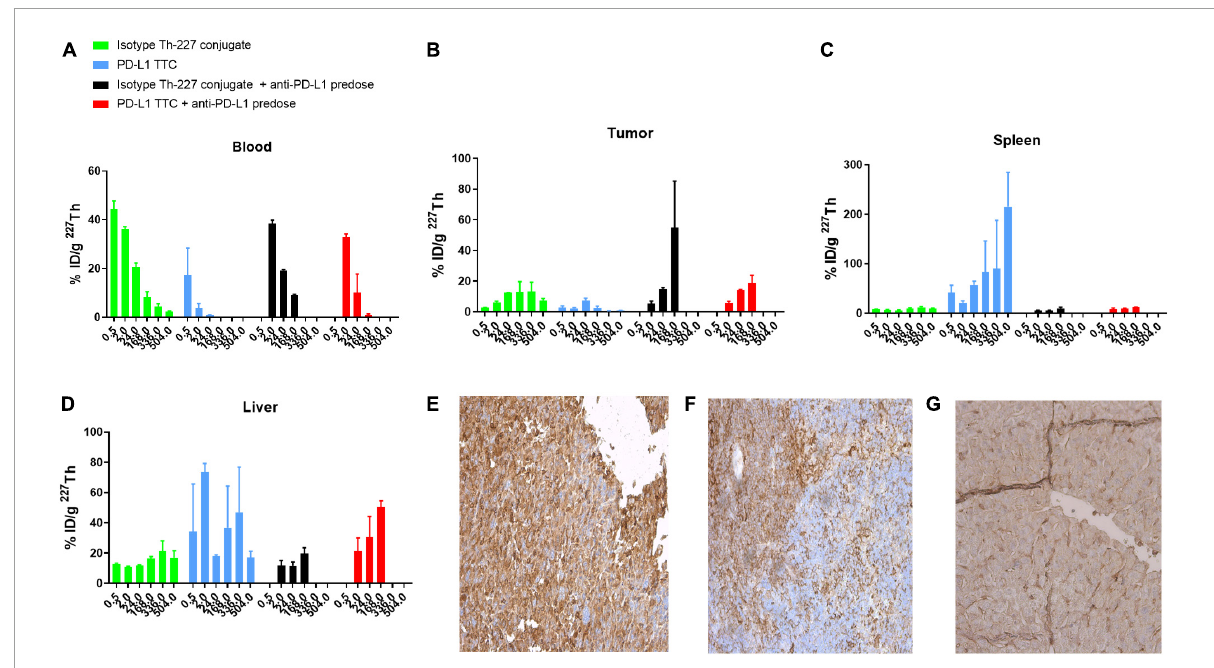
FIGURE3 (A–D) Biodistribution of 500 kBq/kg isotype Th-227 conjugate or PD-L1-TTC in MC-38_EGFP mice without and with 0.2 mg anti-PD-L1 predosing before dosing. n = 3/group/timepoint. (E) PD-L1 expression in MC-38 tumor. (F) PD-L1 expression in C57BL/6 spleen. (G)